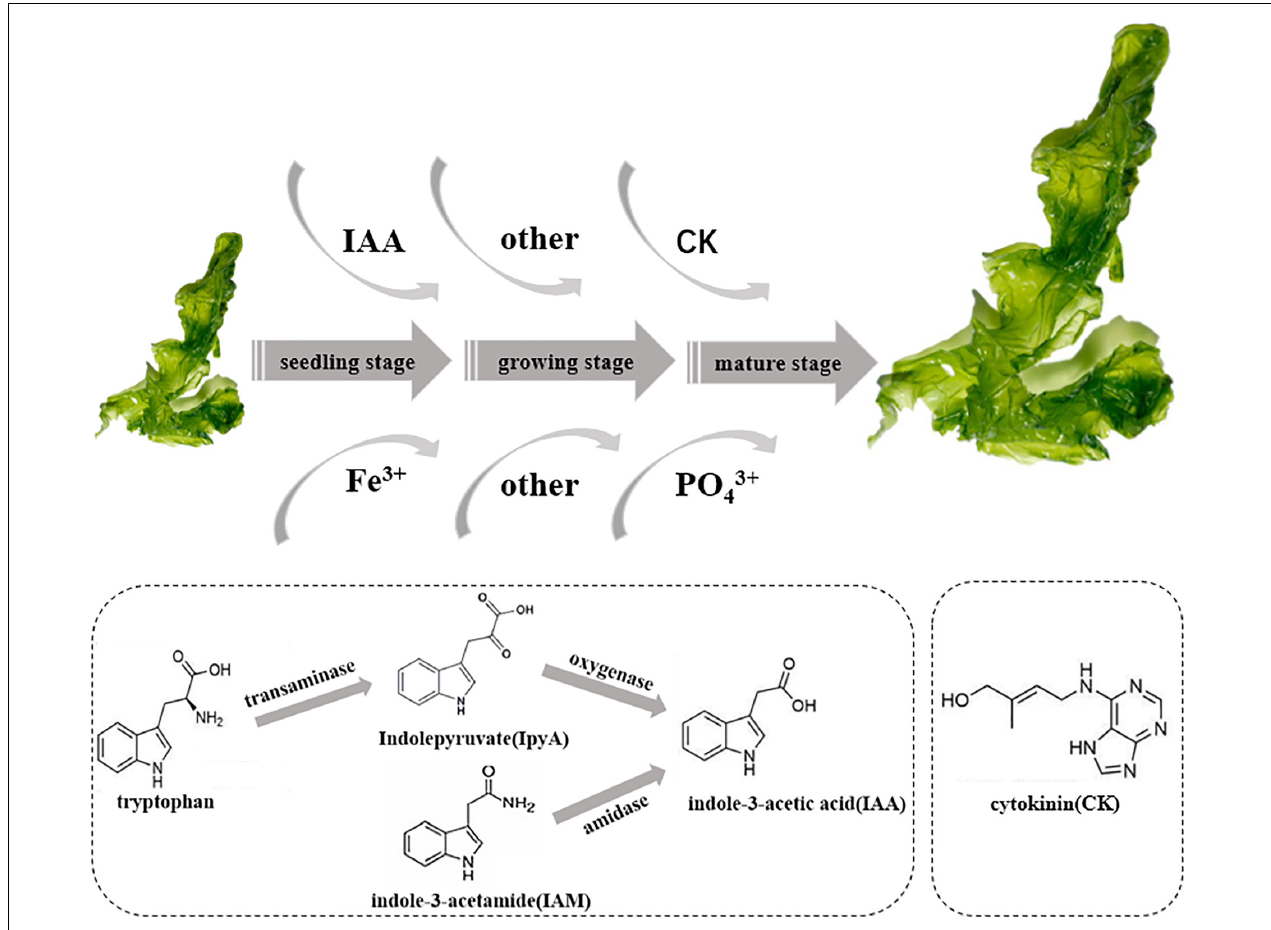
FIGURE 5 | Schematic diagram of potential promoting growth of U. fasciata of strain Hyunsoonleella sp. HU1-3.